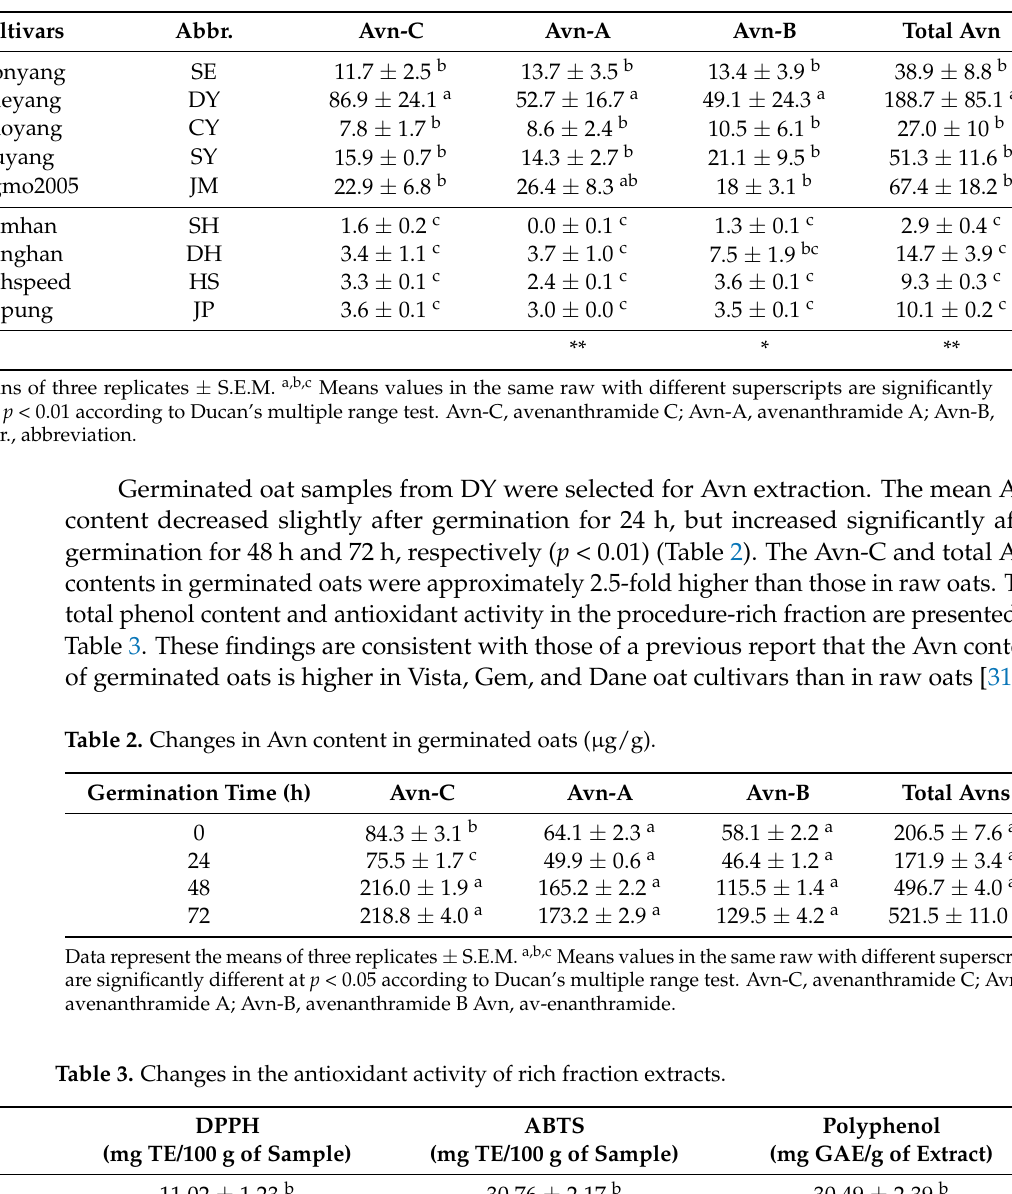
(Table 4). The Avn-C content of Fr. 2 was 16-fold higher than that of raw oats. The β -glucan content of Fr. 2-2 was approximately five-fold lower than that of Fr.